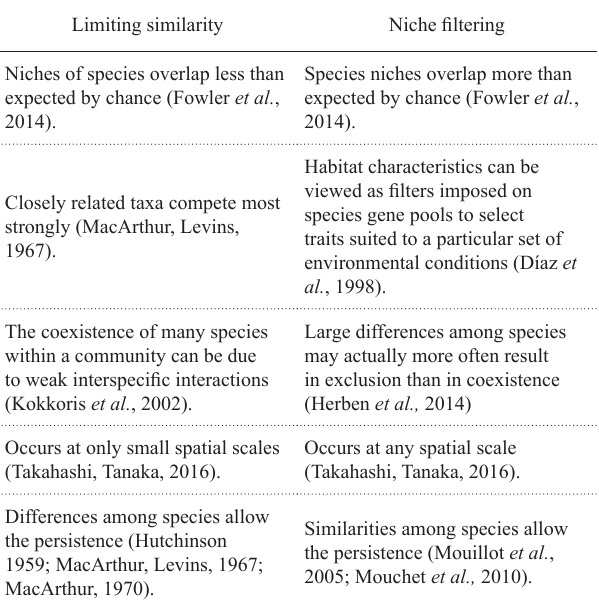
Tab. 1. Main definitions and assertions of each